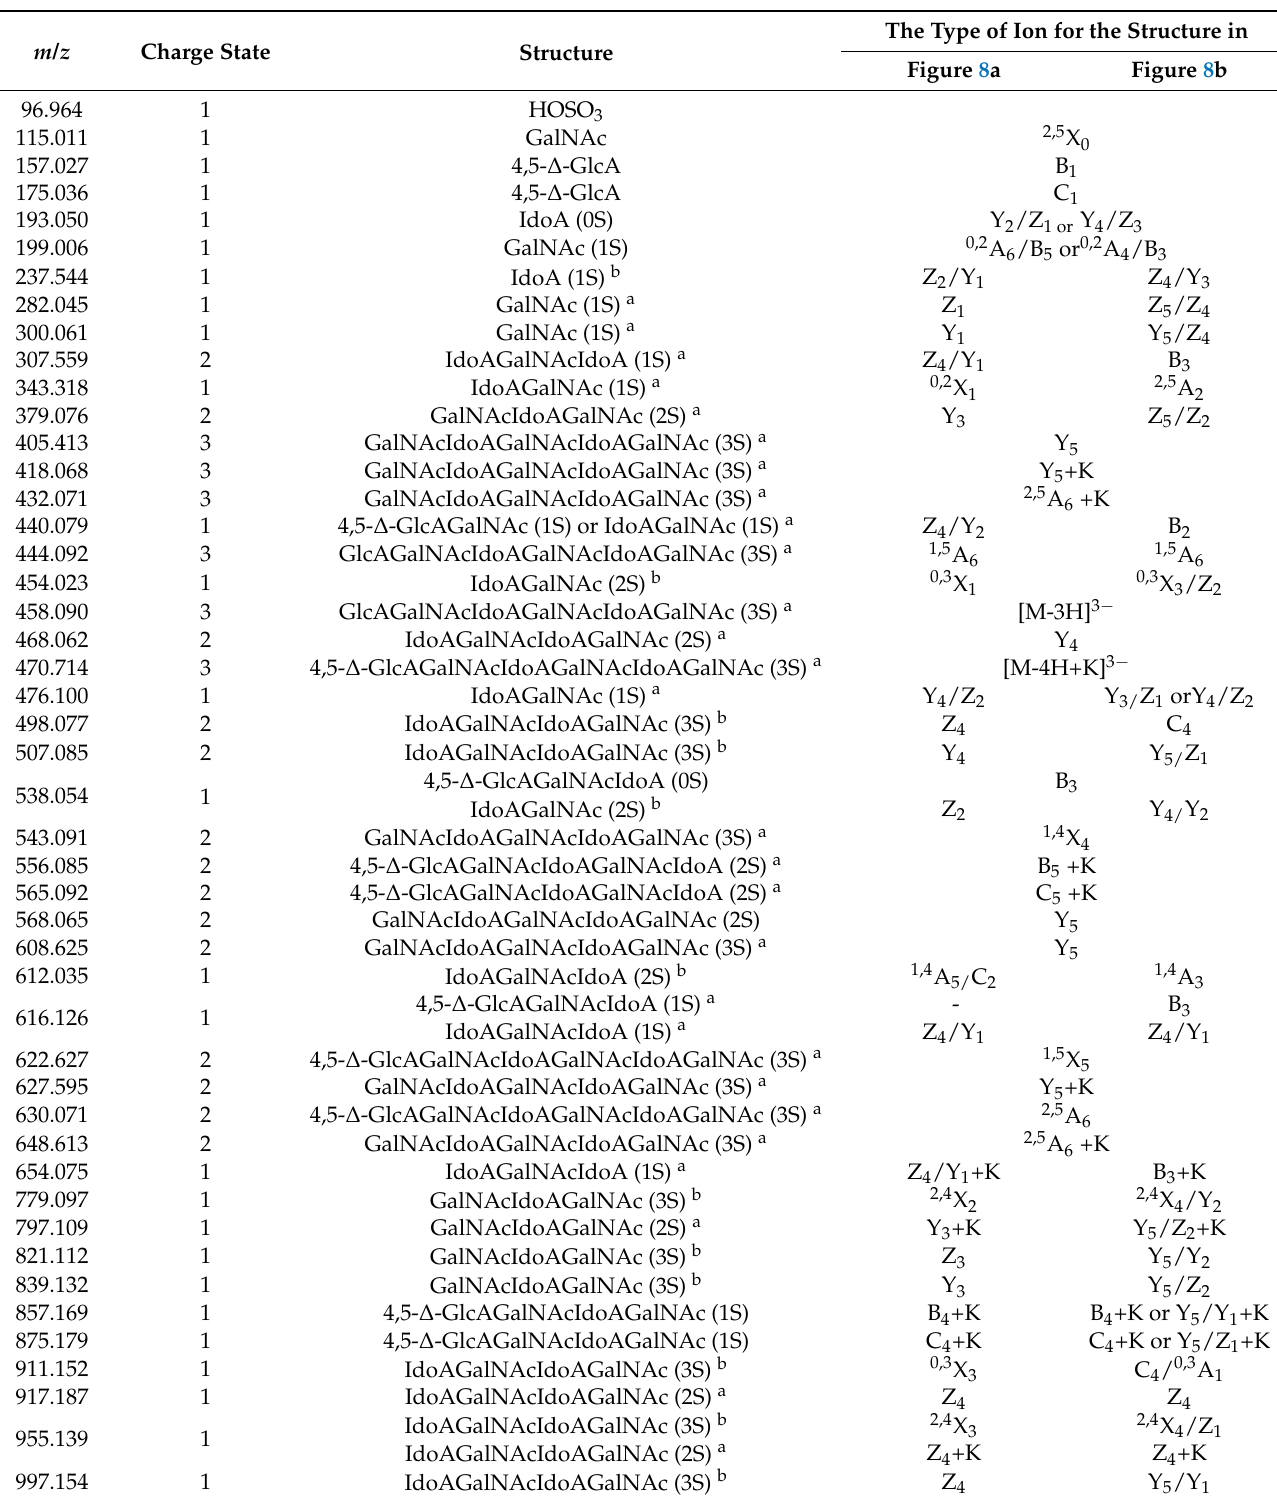
Table 2. m/z values of the fragment ions generated by CID MS/MS experiment in Figure 7 on the trisulfated hexasaccharide detected at m/z 470.714 in the IMS MS and their structure assignment. n S denotes the number of sulfate groups in fragment ions. a Regular sequence ions; b Oversulfated fragment ions.